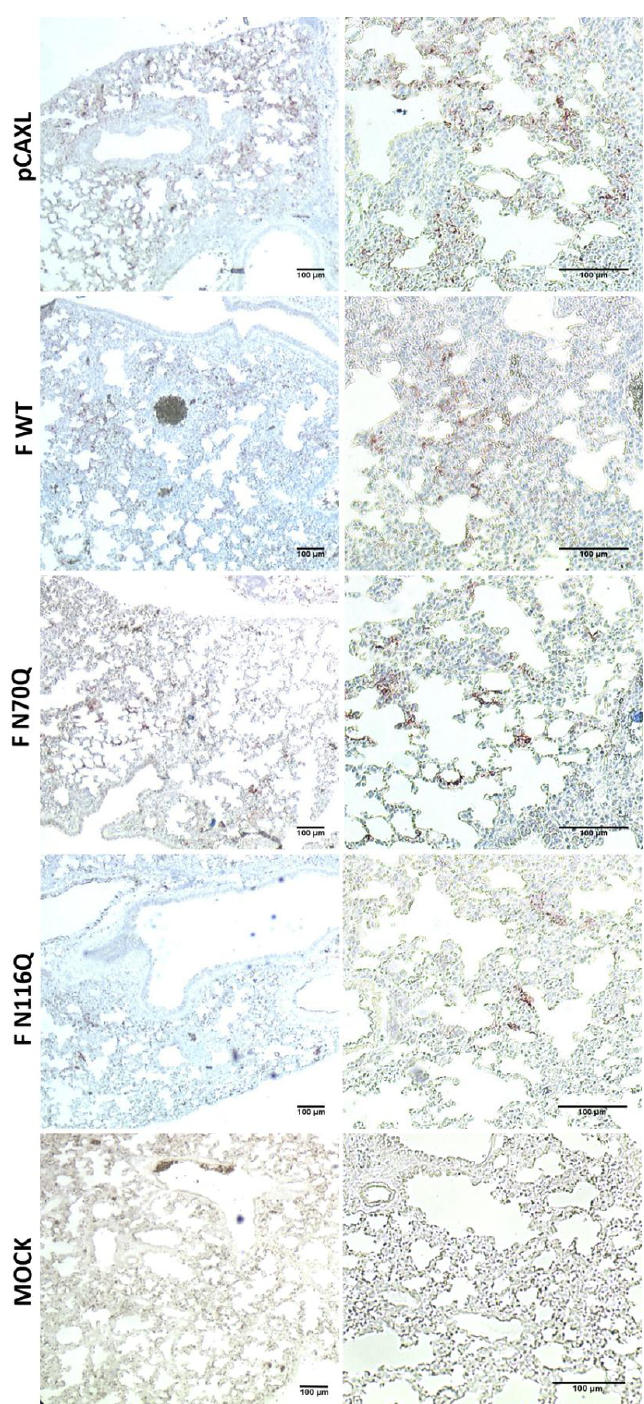
Figure 9. Immunohistochemical staining of PF-fixed, paraffin-embedded lung tissue for RSV antigen. Five days post infection, the right lungs were collected and fixed with 4% formaldehyde (pH 7.4) overnight and further incubated in 60% isopropanol. Lung tissues were paraffin-embedded and stained with goat anti-RSV IgG. Red staining indicates the presence of RSV antigen. Representative images are shown of the indicated groups of immunized mice ( left column: 5×, right column: 10×).